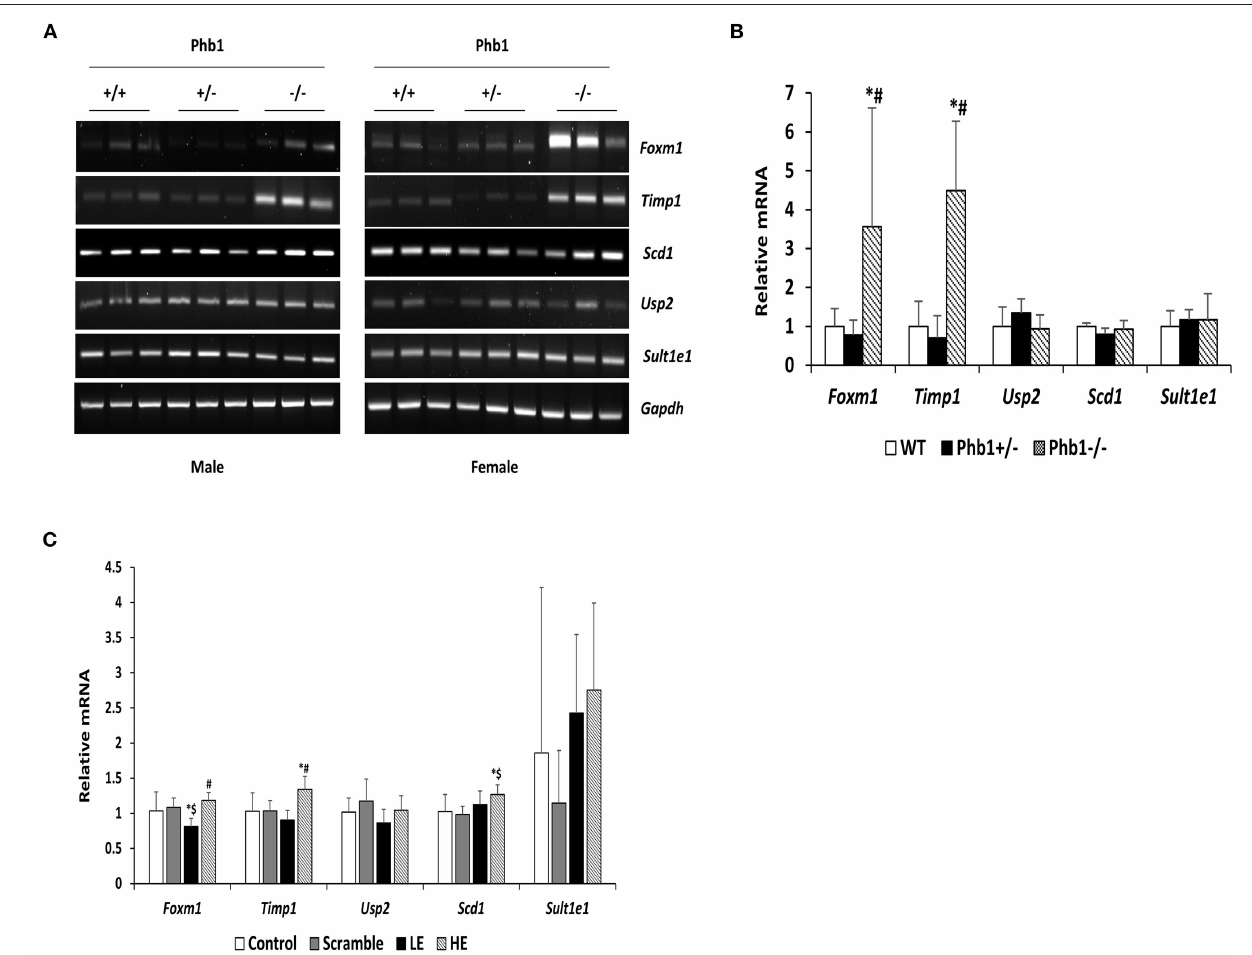
FIGURE 1 | The mRNA expression levels of selected five DE genes in liver tissues and AML12 cells transfected with Phb1 siRNA. (A) The mRNA expression of selected five DE genes in each group of three males and three females ( n = 6/ genotype) was detected by RT-PCR. (B) Band density from RT-PCR was quantified with Image J software and represented as the fold change of control and normalized Gapdh . (C) The mRNA expression levels of selected five DE genes in AML12 cells transfected siPhb1 ( n = 9) were detected by qRT-PCR and normalized b-actin . “LE” means “low efficiency”, represented Phb1 + / − , and “HE” means “high efficiency”, represented Phb1 − / − . All data were expressed as means ± standard deviation. One-way ANOVA followed by Duncan’s post hoc test was performed, and differences were considered statistically significant. * p < 0.05 vs. wild type (WT) and control, respectively. # p < 0.05 vs. Phb1 + / − and low efficiency (LE). $ p < 0.05 vs.